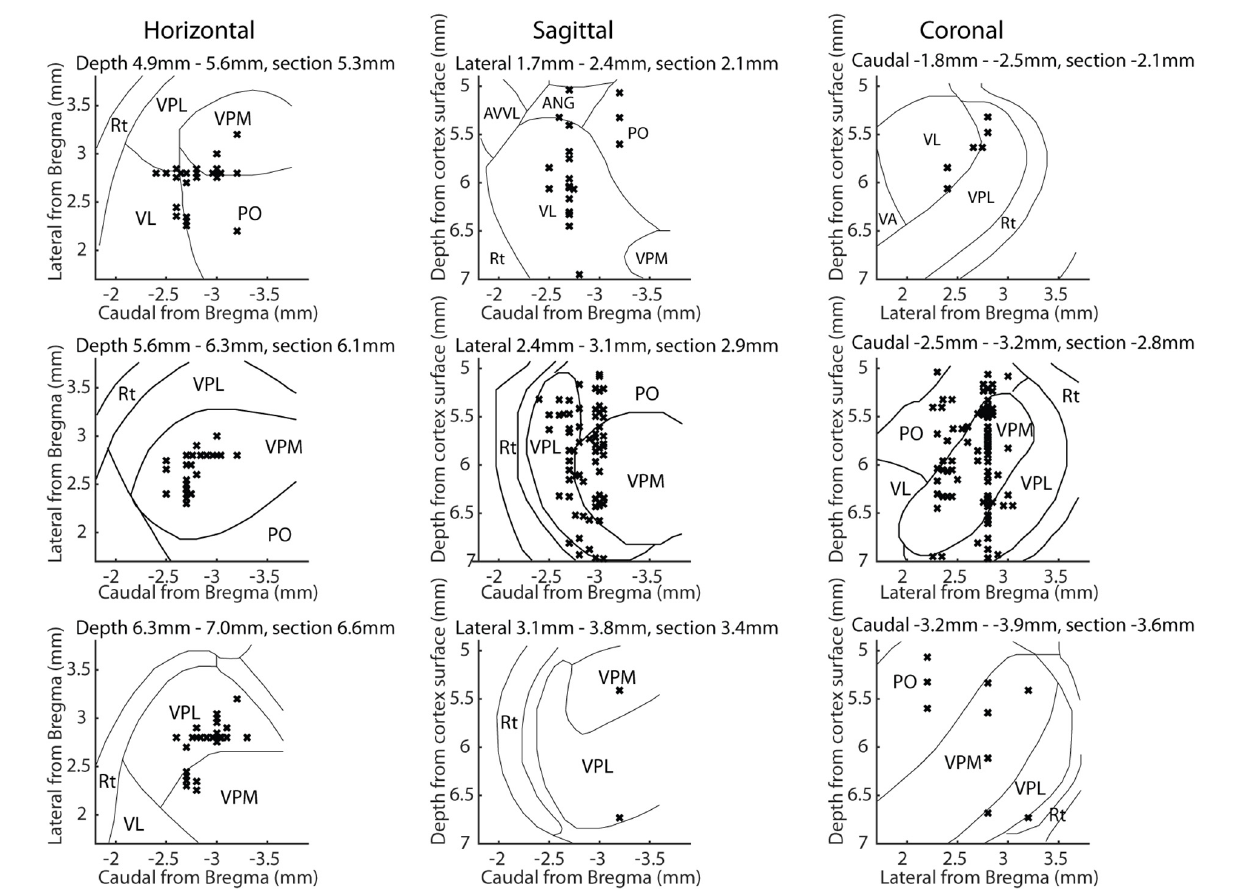
FIGURE 2 | Location of neuronal recording sites in stereotaxic coordinates with the outline of the thalamic nuclei indicated. All thalamic neuron recording sites are shown in horizontal, sagittal and coronal view. For each viewing plane, the plane is split into three ranges and all recording sites within each range is shown. The ranges of each outline level are here presented as lower limit-upper limit the plane of the outline section illustrated; Paxinos and Watson, 2006). The left column shows the horizontal plane with top row: 4.9–5.3 mm (5.3 mm), middle row: 5.6–6.3 mm (6.1 mm) and bottom row: 6.3–7 mm (6.6 mm). In the same manner the middle column shows the sagittal plane with top row: 1.7–2.4 mm (2.1 mm), middle row 2.4–3.1 mm (2.9 mm) and bottom row: 3.1–3.8 mm (3.4 mm). Right column show the coronal range with top row_ –1.8 to –2.5 mm (–2.1 mm), middle row: –2.5 to –3.2 mm (–2.8 mm) and bottom row: –3.2 to –3.9 mm (–3.6 mm). Rt,